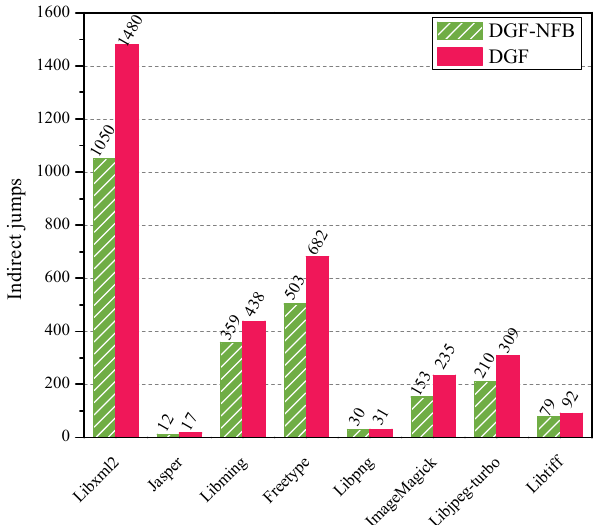
Figure 10. The total number of indirect jumps resolved by two approaches on 8 benchmarks after 20 h. The red bar (DGF) represents our approach with iterative feedback, and the green bar (DGF-NFB) is the